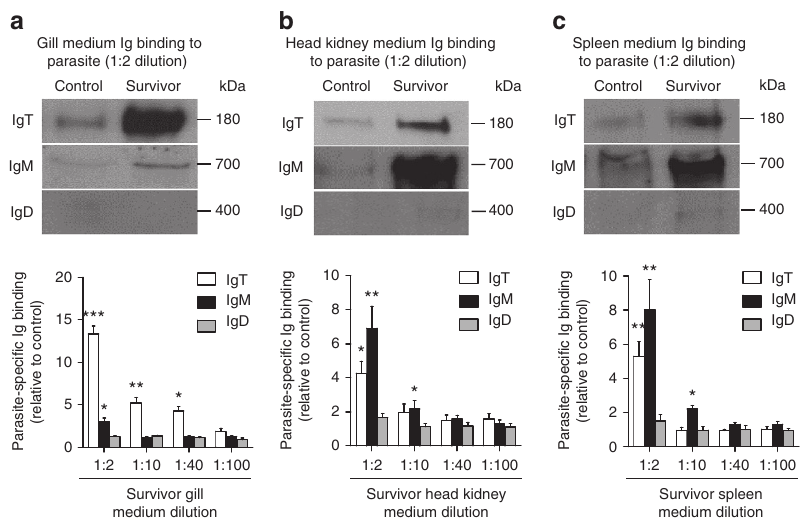
Figure 7 | Local IgT-, IgM- and IgD-specific responses in gill explants of survivor fish. Gill, head kidney and spleen explants ( B 50mg each) from control and survivor fish were cultured for 7 days. ( a – c ) Western blot analysis of IgT-, IgM- and IgD-specific binding to Ich in the culture medium of gill ( a , upper), head kidney ( b , upper) and spleen ( c , upper) (dilution 1:2) from control and survivor fish. ( a – c ) IgT-, IgM- and IgD-specific binding to Ich in dilutions of culture medium from gill ( a , lower), head kidney ( b , lower) and spleen ( c , lower) from control and survivor fish, measured by densitometric analysis of immunoblots and presented as relative values to those of control fish ( n ¼ 9–12 per group). * P o 0.05, ** P o 0.01 and *** P o 0.001 (unpaired Student’s t -test). Data are representative of at least three independent experiments (mean and